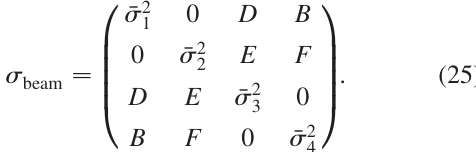
Figure 2(c) represents the asymmetric FBT case, where b ¼ 1 , e ¼ (cid:1) 1 , d ¼ 0 , and the initial beam shape is ¼ (cid:7) ¼ 1 . varied. For both curves, the divergences (cid:7) 2 4 ¼ 1 and (cid:7) For the solid line, (cid:7) is decreased, causing 3 1 the change in the initial emittance ratio. For the dot-dashed line, (cid:7) is decreased while (cid:7) is increased, keeping the 1 3 ¼ 1 . In other words, the solid (cid:7) product (cid:7) 1 3